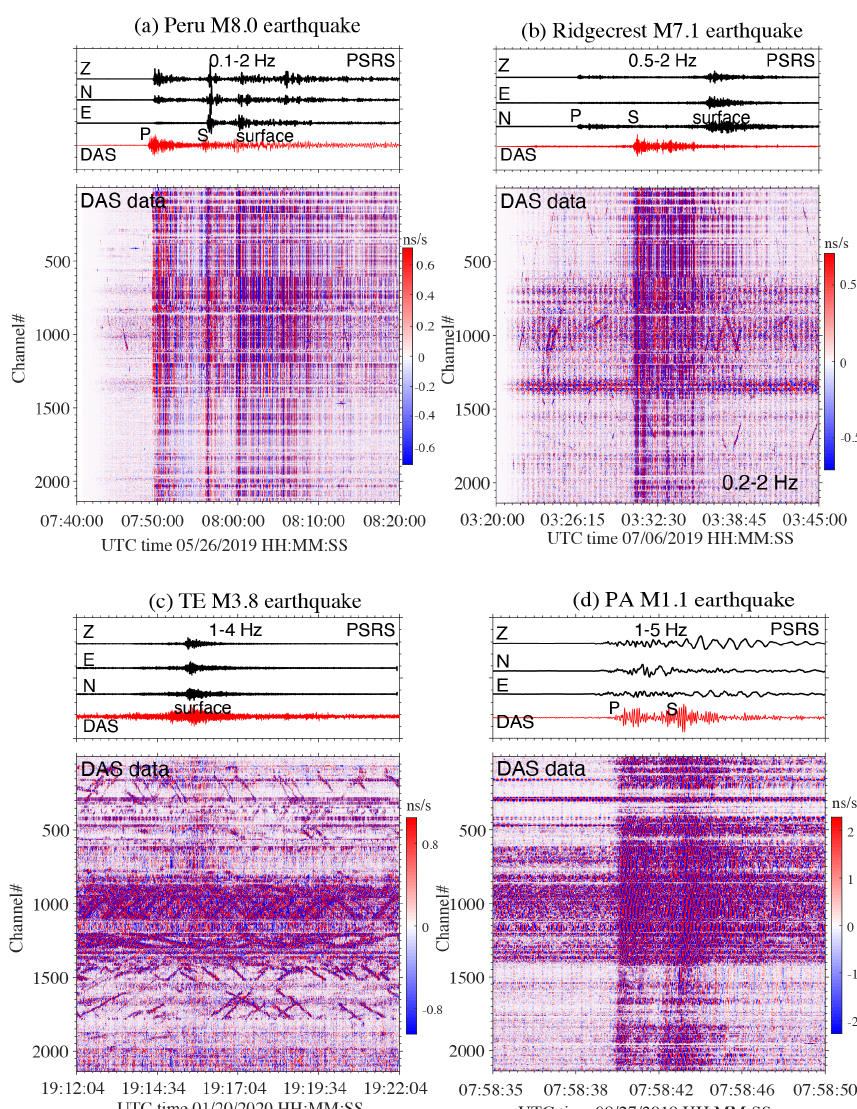
Figure 6. DAS recordings of earthquakes: (a) Peru M8.0 earthquake on 26 May 2019; (b) Ridgecrest M7.1 on 6 July 2019; (c) Tennessee M3.8 on 20 January 2020, and (d) PA M1.1 on 27 August 2019. The top panel shows reference seismograms from nearby seismic station PSRS. The color bar scale hereafter is in raw DAS